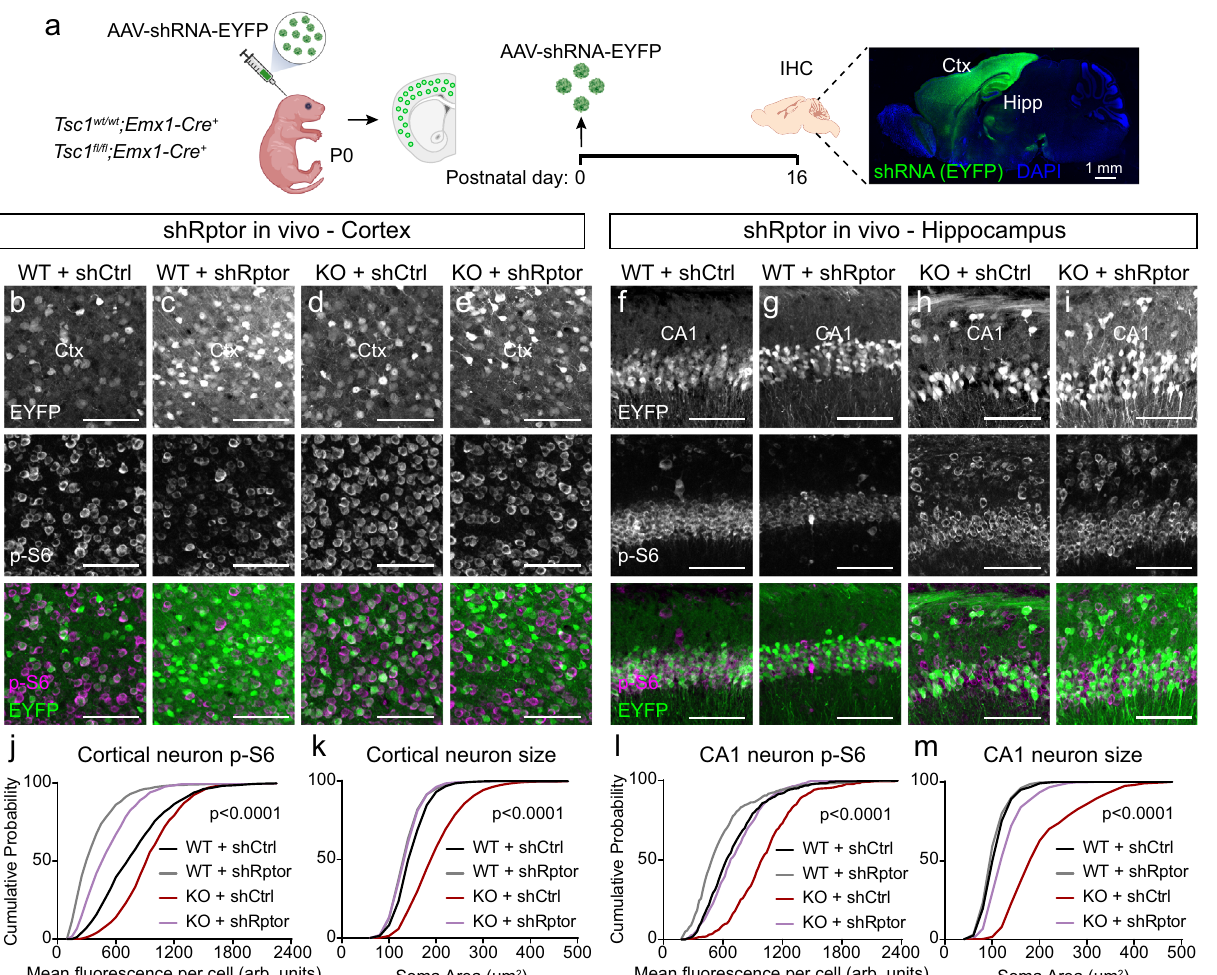
Fig. 8 | Postnatal Raptor reduction improves cellular phenotypes in Tsc1-cKO mice.a Schematicoftheexperiment,createdwithBioRender.com.Examplesagittal brain image of an injected mouse showing EYFP expression in green and DAPI in blue. This experiment was replicated twice. Ctx cortex, Hipp hippocampus. Scale bar = 1 mm. b – e Representative images of the somatosensory cortex of Tsc1 wt/wt ; Emx1-Cre + (WT, b , c ) and Tsc1 fl / fl ; Emx1-Cre + (KO, d , e ) mice injected with either shRptor-EYFP or shCtrl-EYFP virus showing EYFP (top panels) and p-S6 240/ 244 immunostaining (middle panels). Bottom panels show merged images. Scale bars=100 μ m. f – i RepresentativeimagesoftheCA1regionofWT( f , g )andKO( h , i ) miceinjectedwithshRptor-EYFPorshCtrl-EYFPvirusshowingEYFP(toppanels)and p-S6 240/244 immunostaining (middle panels). Bottom panels show merged ima- ges. Scale bars = 100 μ m. j Cumulative distributions of p-S6 levels in cortical EYFP+ neurons for the indicated genotypes. n = 1086 WT+shCtrl, 1095 WT+shRptor, 1095 Tsc1-KO+shCtrl, and 1087 Tsc1-KO+shRptor neurons from 6 mice per group. Kruskal – Wallis test, p < 0.0001; WT+shCtrl vs WT+shRptor, p < 0.0001; WT+shCtrl vsTsc1-KO+shCtrl, p <0.0001;WT+shCtrlvsTsc1-KO+shRptor, p <0.0001;Tsc1-KO +shCtrl vs Tsc1-KO+shRptor, p < 0.0001; Dunn ’ s multiple comparison